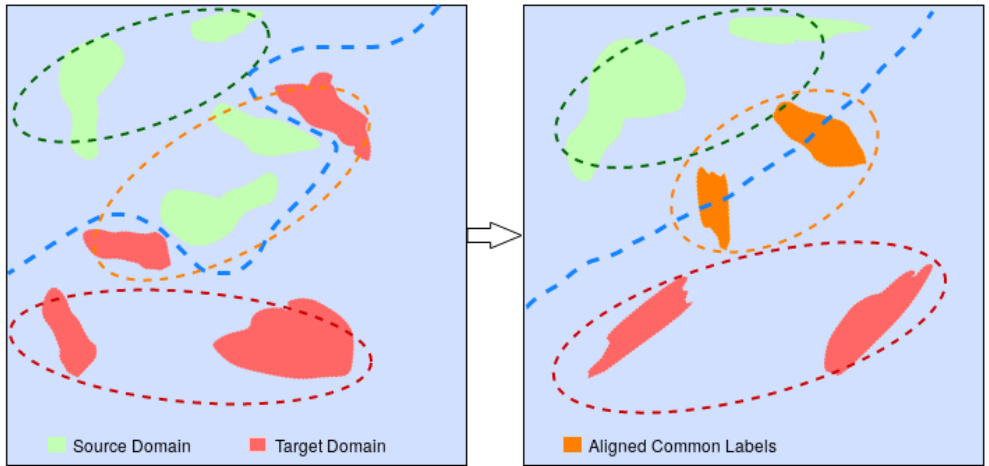
Figure 1. Alignment with source and target outliers. ( Left ): Source and target domain distributions. The blue dashed line denotes a decision boundary before adaptation. ( Right ): The effect of adaptation; common labels align, while source/target outlier instances are mainly ignored. This is best viewed in